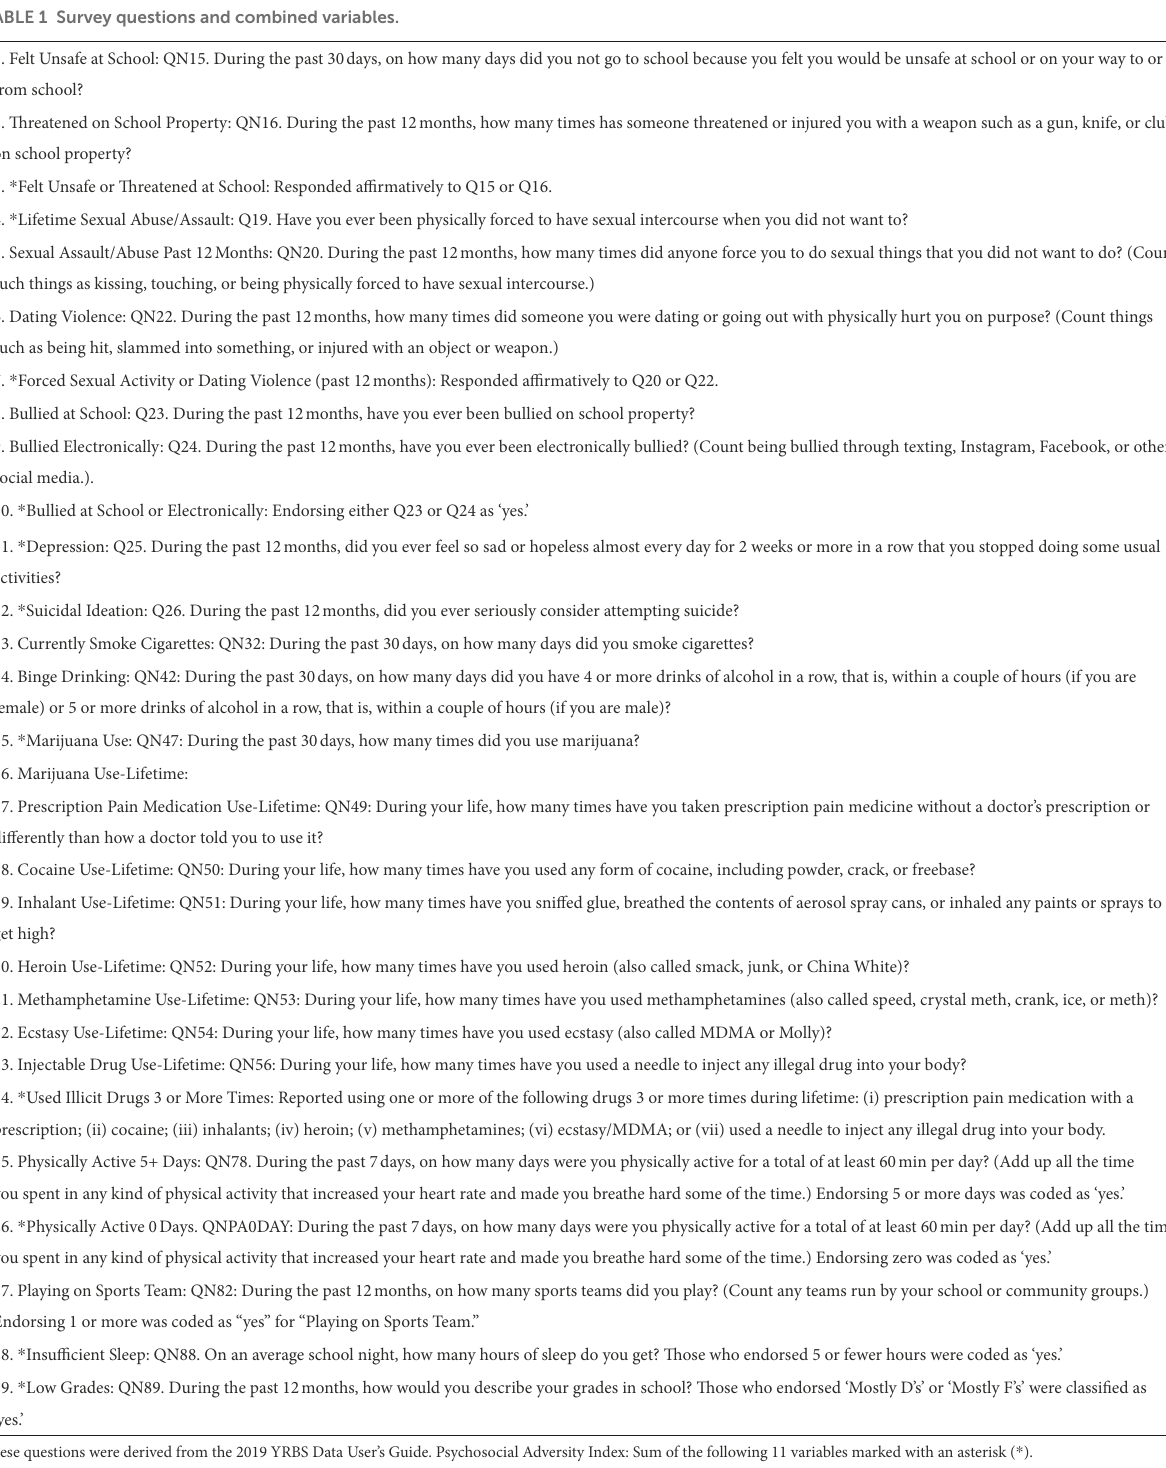
TABLE 1 Survey questions and combined